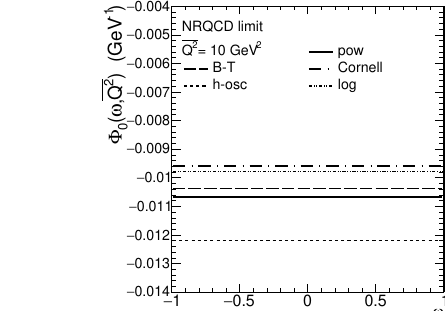
Figure 4 . Antisymmetric F A and symmetric F S form factors as functions of asymmetry parameter ω for several values of Q 2 in the range (0 . 1 – 100) GeV 2 for the power-like potential. show maps of helicity form factors F changes its sign when crossing the Q 2 Also these plots were obtained for the power-law potential. Qualitatively, the plots for different potentials look